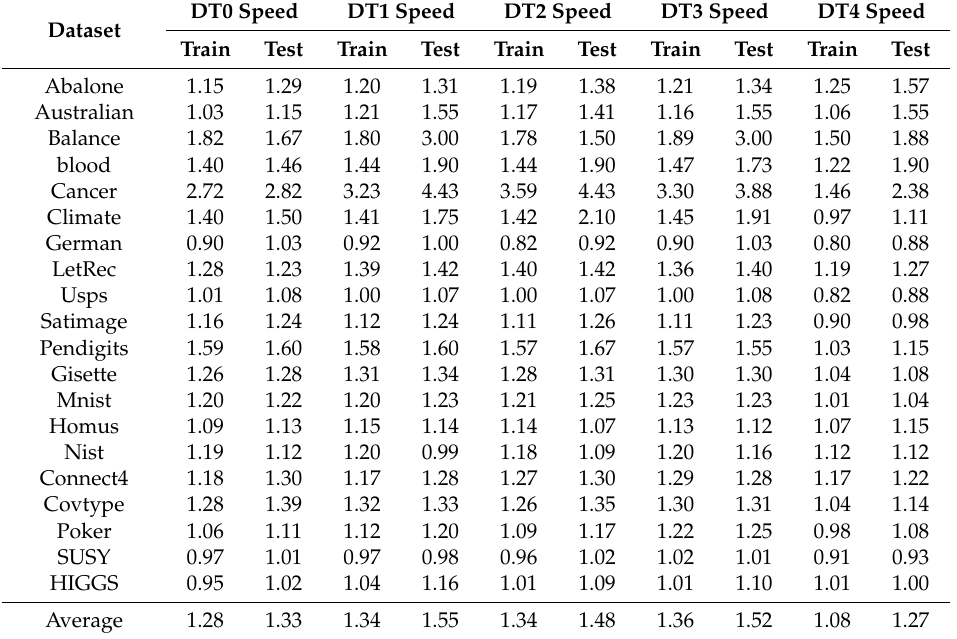
Table 7. Speed-up results (training and testing phases) of the proposed methods DT0–DT4 compared to the FPBST.